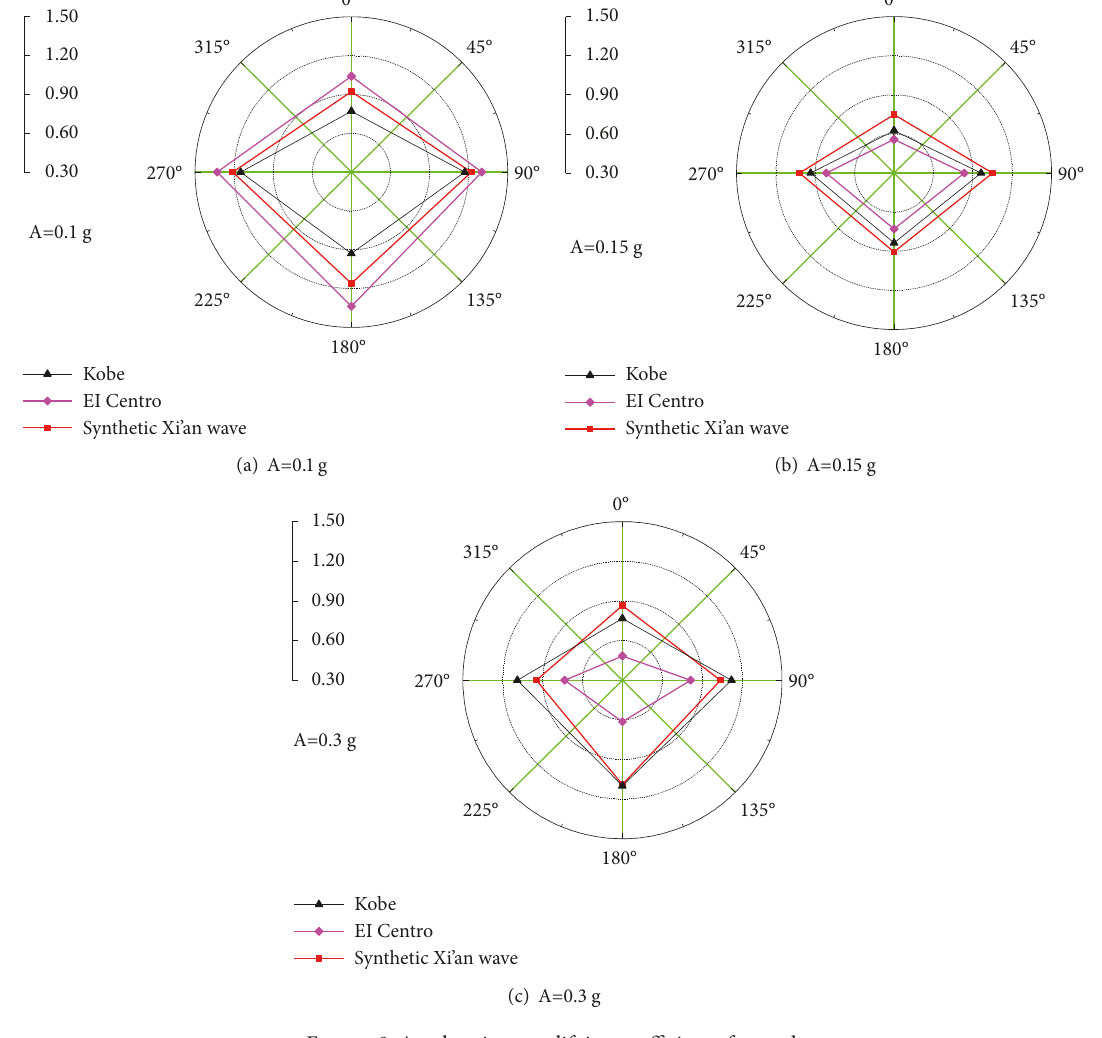
Figure 8: Acceleration amplifying coefficient of tunnel.